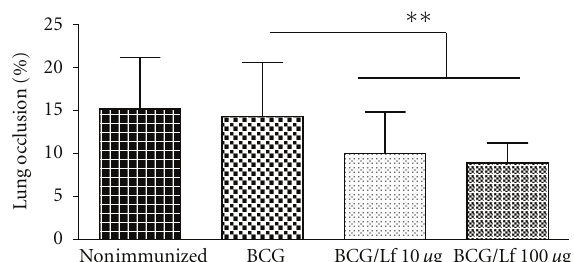
Figure 4: Quantitative analysis of histopathological protective response due to lactoferrin vaccination. Quantitative assessment of BCG immunization with or without lactoferrin (at 10 or 100 μ g/mouse) as described in Figure 2 revealed significant reduc- tion in lung occlusion following aerosol infection with virulent mycobacteria at 65 days postchallenge. Quantitation of lung occlu- sion percent was completed using Image J (NIH) by comparing total section area with total area of granulomas. Number of animals per group ranged from 6 controls to 10 in the vaccinated groups. ∗∗ P < . 01; NS: no significant di ff erence between